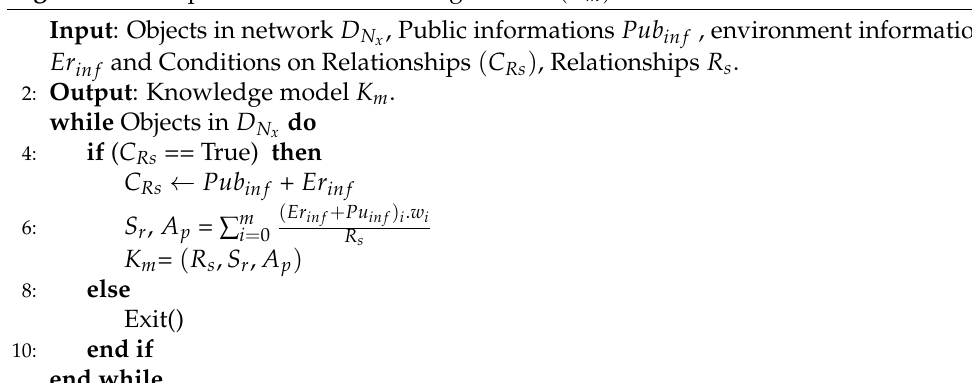
Algorithm 2 Proposed R-ANN knowledge model ( K m